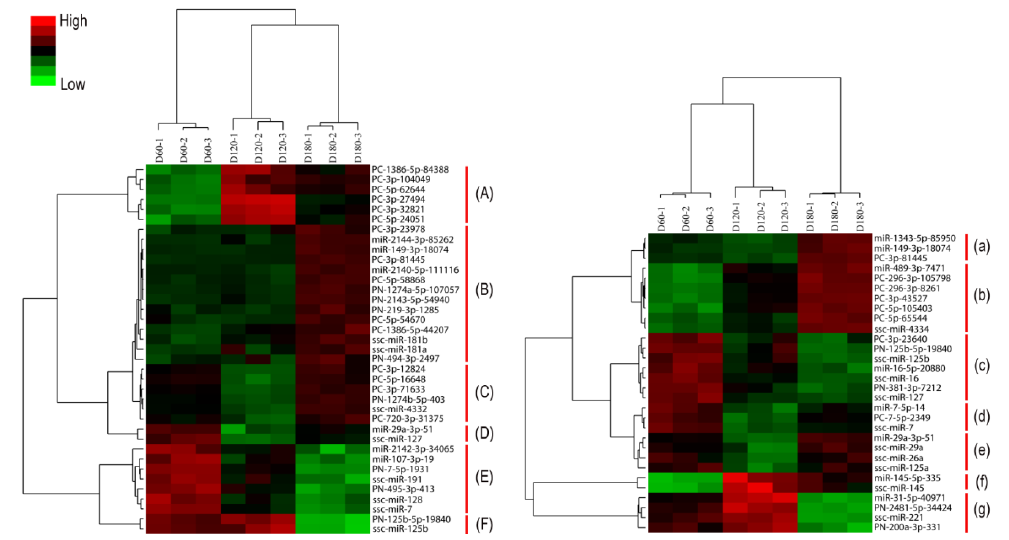
Figure 2. Differentially expressed miRNAs in the porcine hypothalamus and pituitary identified by SAM analysis. D60: day 60; D120: day 120; D180: day 180. A normalized and log-transformed data adjustment was performed in the cluster analysis